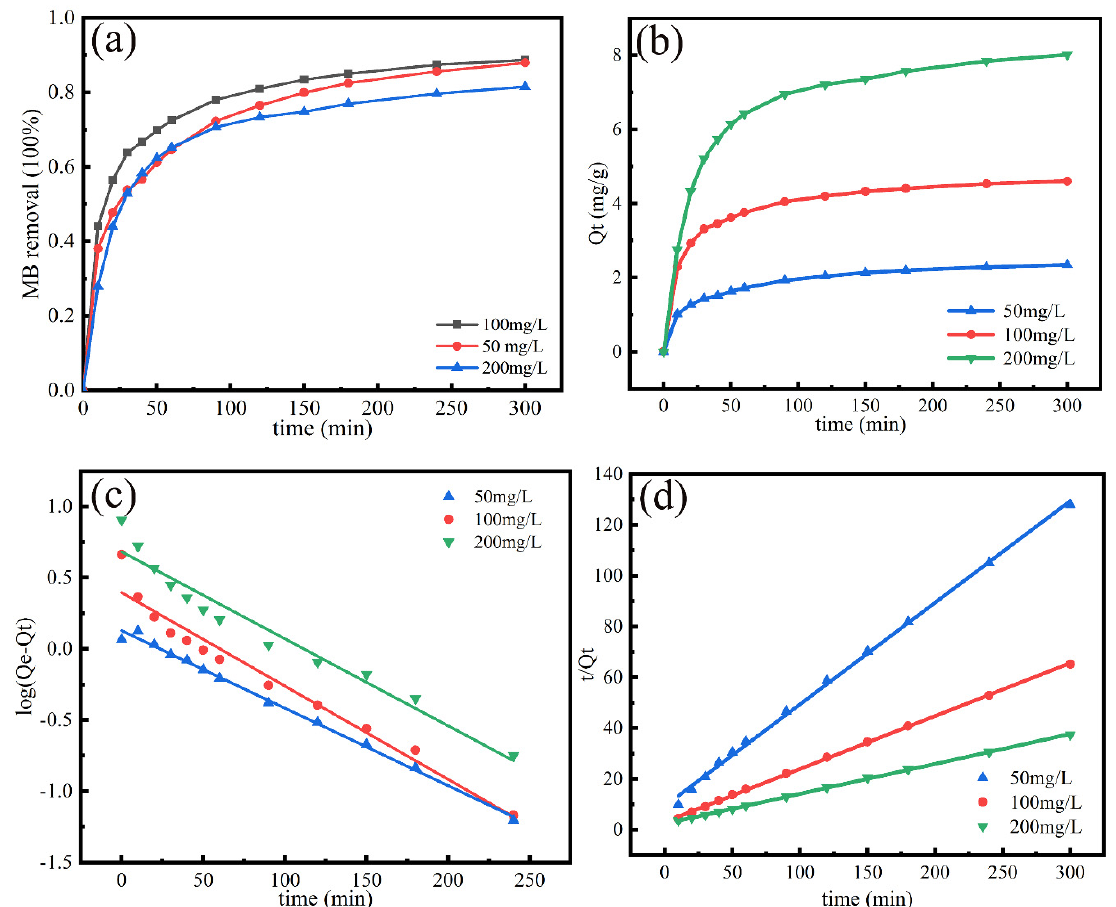
Figure 9. ( a ) Change of the adsorption capacity and removal efficiency with adsorption time, ( b ) q e of Ca-MOF/ABS/TPU for MB adsorption; ( c ) pseudo-first; ( d ) pseudo-second. Table 2. Kinetic parameters for MB adsorption on the Ca-MOF/ABS/TPU 3D skeleton. Model